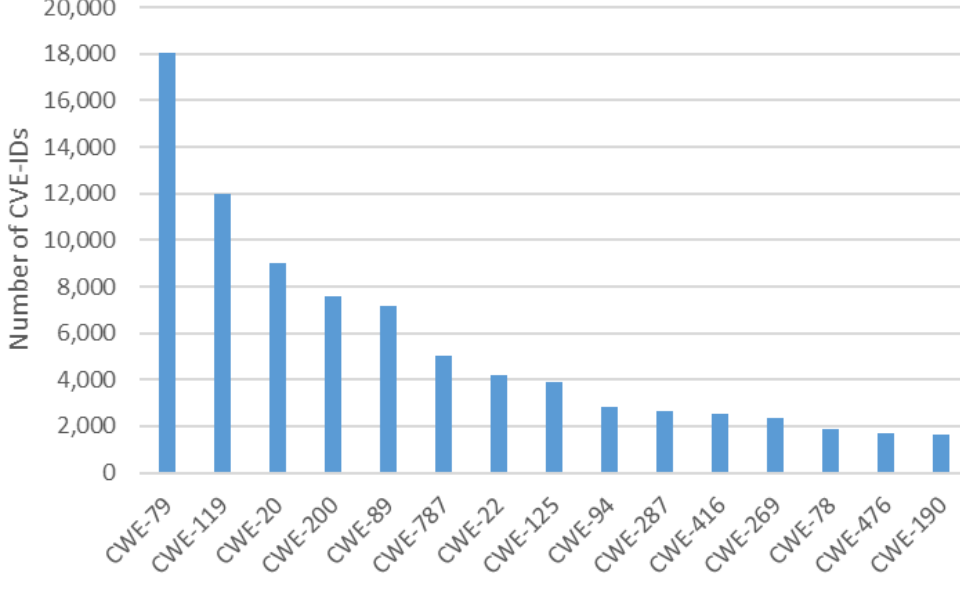
Figure 10. Vulnerability distribution by